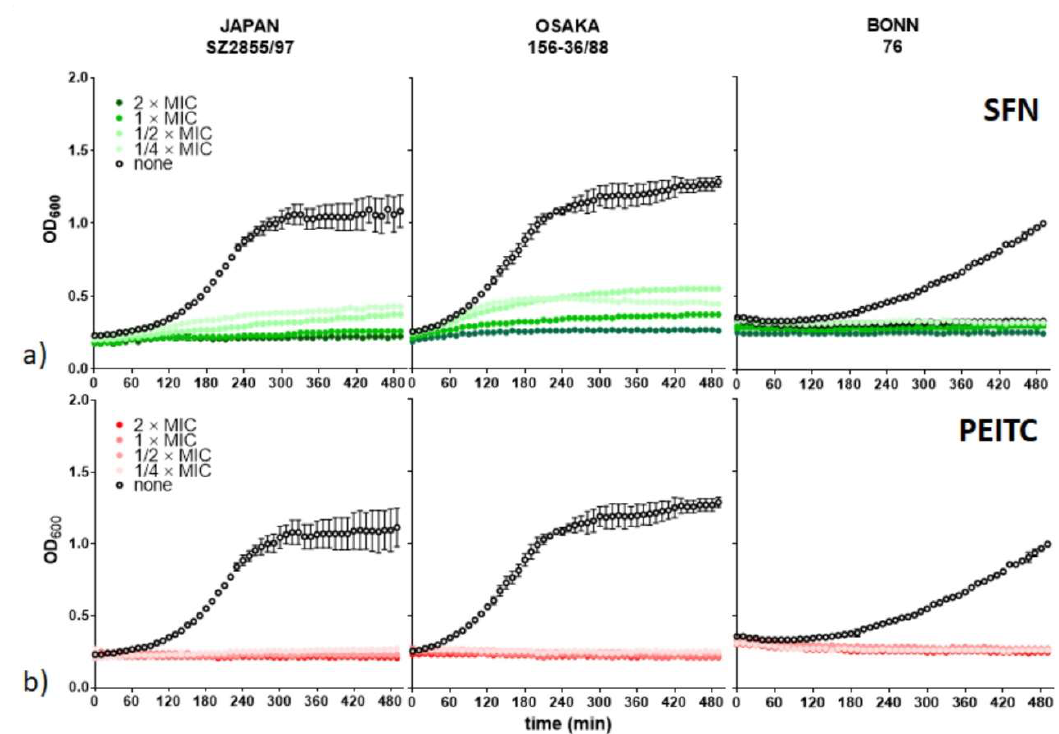
Nutrients 2021 , 13 , x FOR PEER REVIEW Figure 1. SFN and PEITC affect bacterial growth. S. dysenteriae isolates (indicated above graphs) were cultured in the presence of ( a ) SFN and ( b ) PEITC at indicated concentrations related to the MIC determined previously (Table 1).